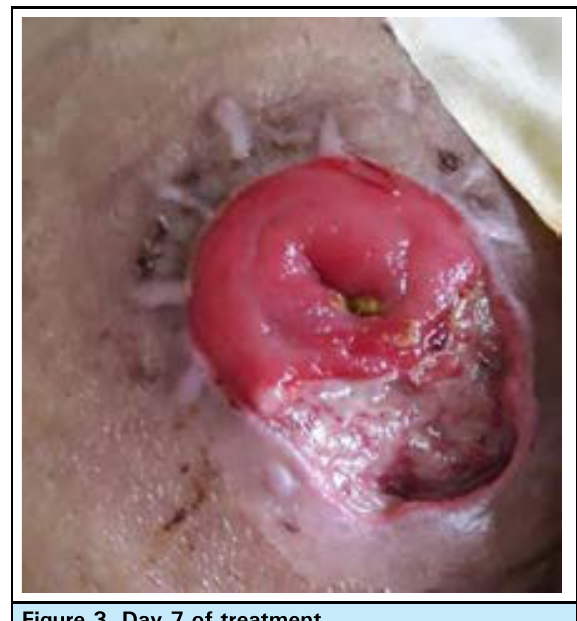
Figure 3. Day 7 of